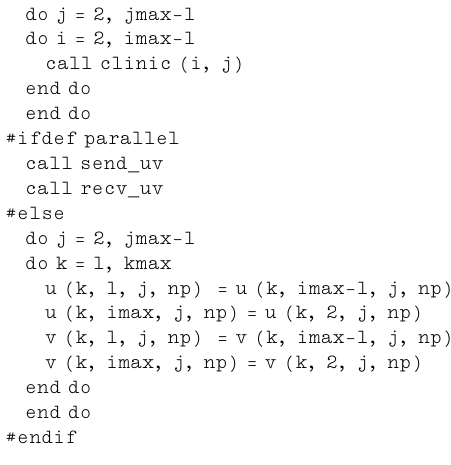
Fig. 1. To accommodate the exchange of boundary data, for a regular two-dimensional decomposition, an additional outer halo, R 0 , is declared to receive the values that have been calculated and sent from the boundary halo, S 0 , of adjacent sub domains